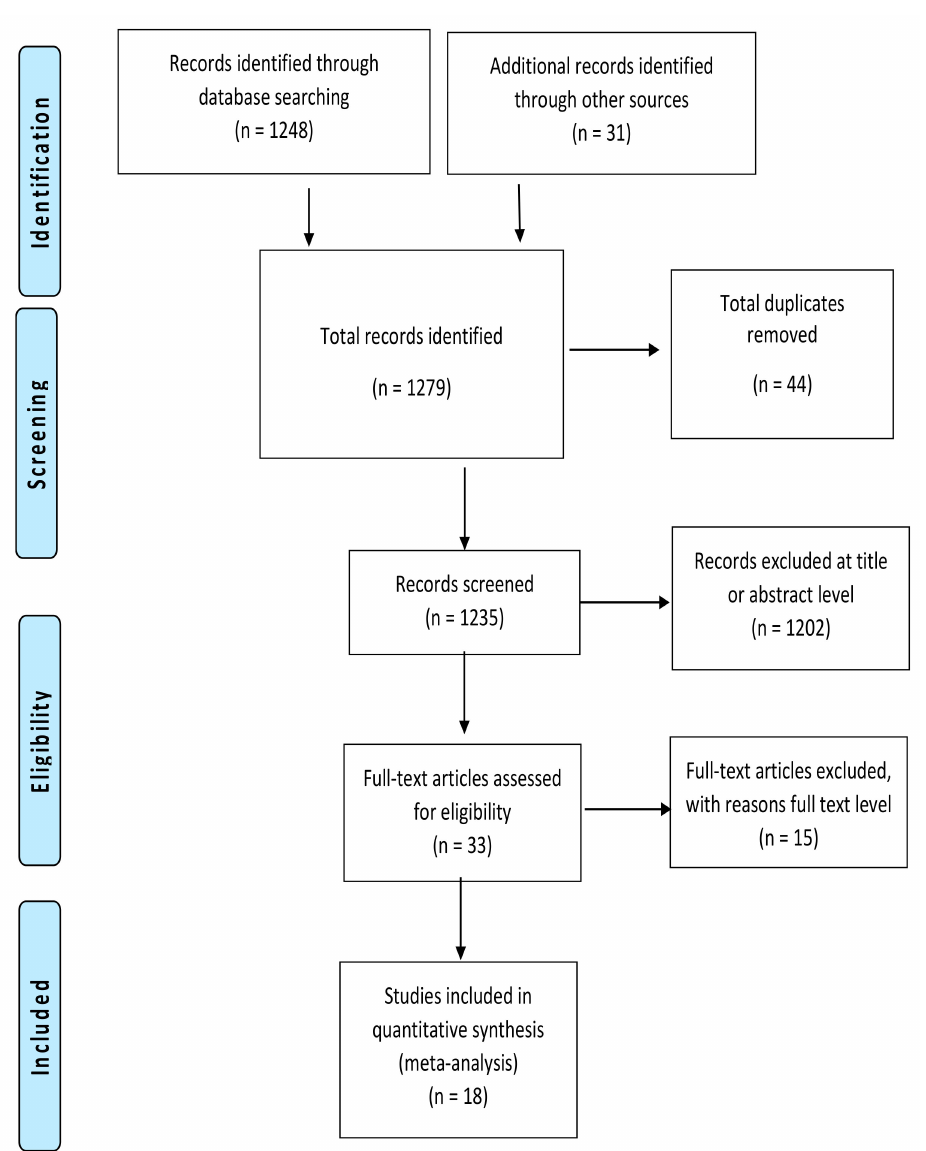
Figure 1. PRISMA flow diagram: Summary of studies search and selection